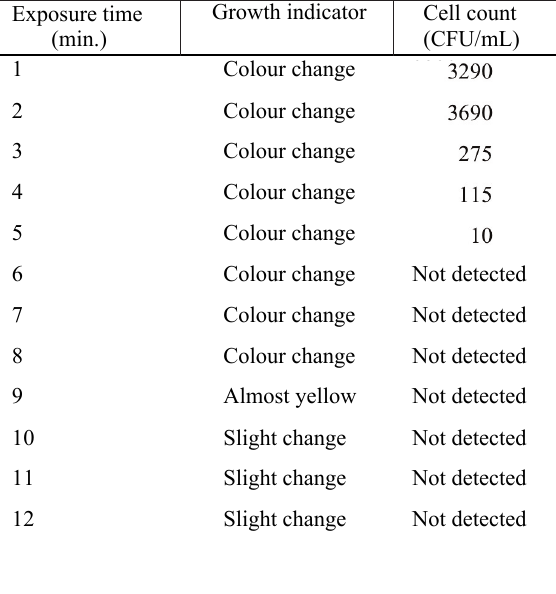
Table 1. Survival rate of G. stearothermophilus exposed to 400 ppm HPV in the tent (Fig. 2.b) as a function of time, using the classical microbiological growth test as a reference study